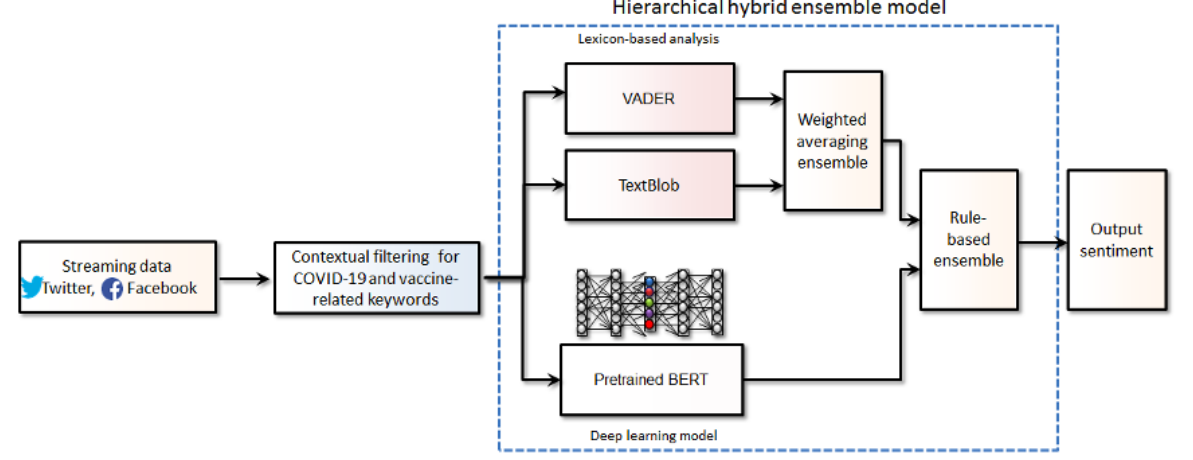
Figure 1. Hierarchical hybrid-ensemble–based artificial intelligence model and data pipeline for thematic sentiment analysis. BERT: Bidirectional Encoder Representations from Transformers, VADER: Valence Aware Dictionary for Sentiment Reasoning.